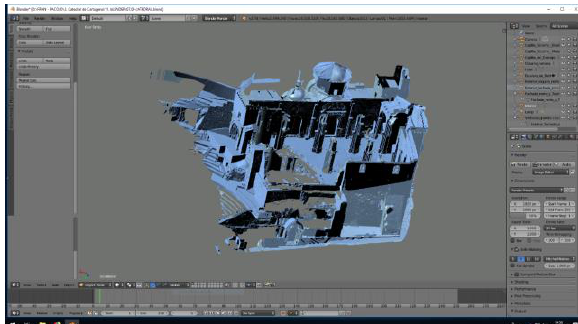
Figure 10. Example of the optimization of the triangular mesh with the use of the Blender program.